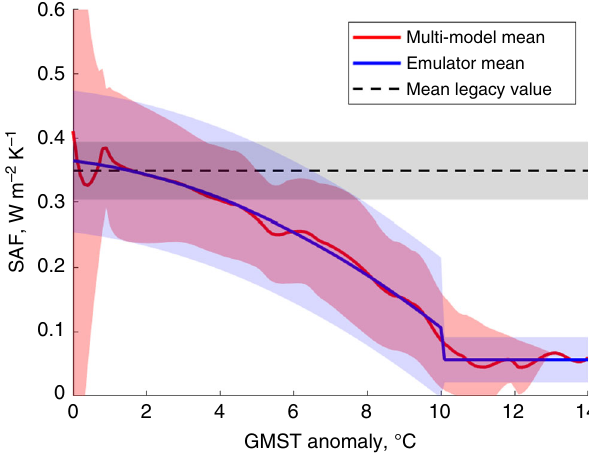
Fig. 8 Emulator of the global surface albedo feedback and its legacy value. Global SAF as a function of the GMST rise relative to pre-industrial conditions obtained from 16 CMIP5 GCMs using the ALL/CLR method. Red line: multi-model mean; shaded red area: ±1SD; blue line and shaded area: mean and ±1SD of the two-segment emulator. The dashed line and grey shaded area show statistical mean and ±1SD of the SAF averaged between pre-industrial conditions and the level of warming corresponding to the 2xCO 2 ECS experiment (mean value of 2.8°C, 5 – 95% range of 1.7°C – 4.2°C according to IPCC AR5). Source data are provided as a Source Data fi